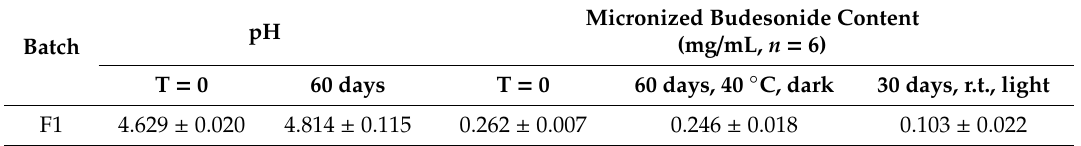
Table 3. Chemical characterization of the in-use preparation in the hospital pharmacy (F1: XG 2%). pH values and drug content at preparation time (T = 0) and at the end of the storage period in an incubator in dark condition (T = 60 days). Drug content determined after 30 days at room temperature (r.t.) exposed at the